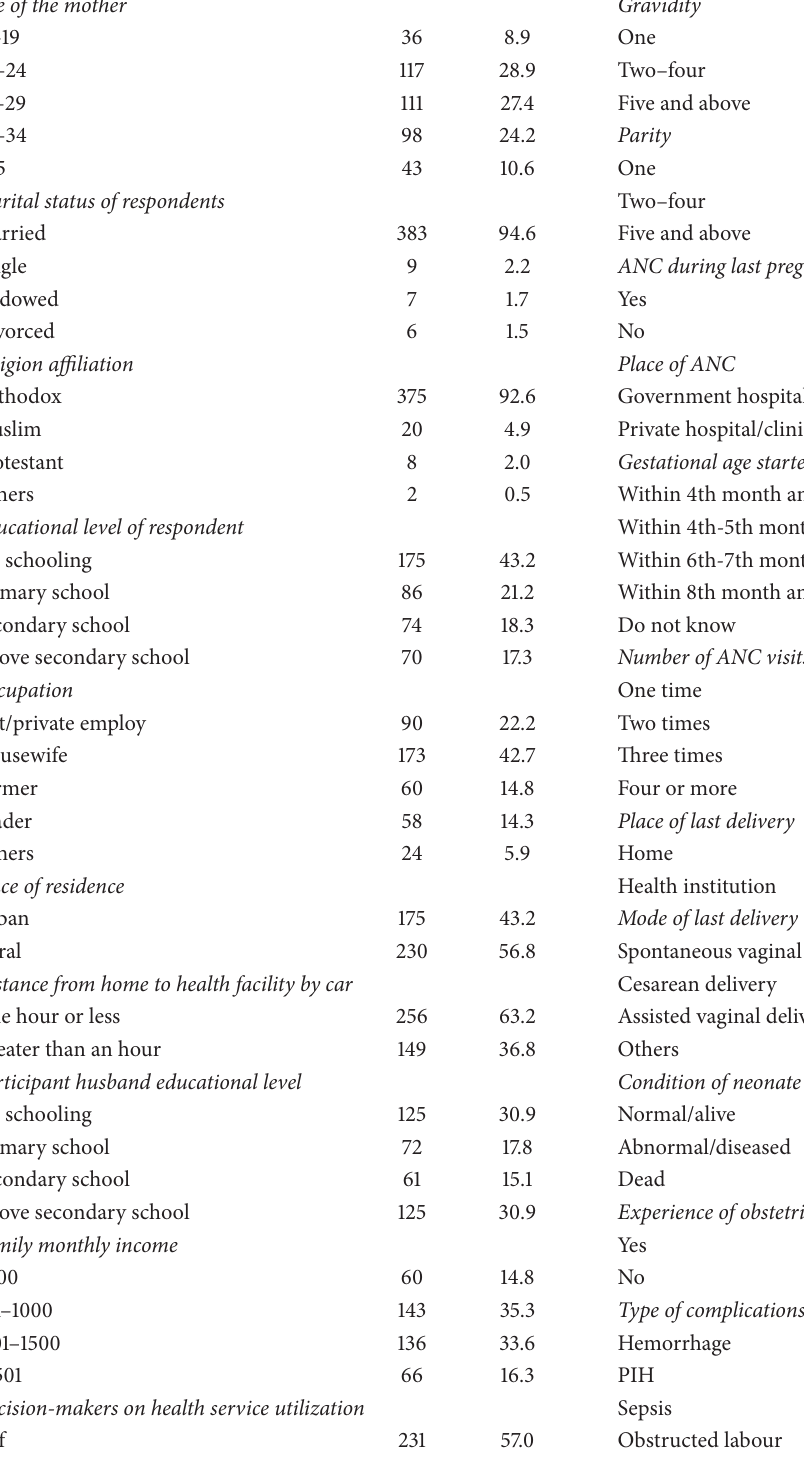
Table 2: Obstetric characteristic of postnatal mothers ( 𝑛 = 405 ) of Mechekel district health centers, East Gojjam zone,